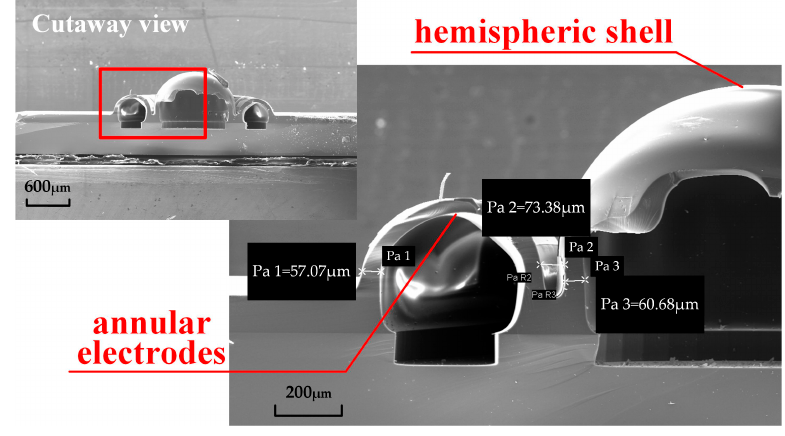
Figure 9. Cutaway view of annular electrodes and hemispheric shell.